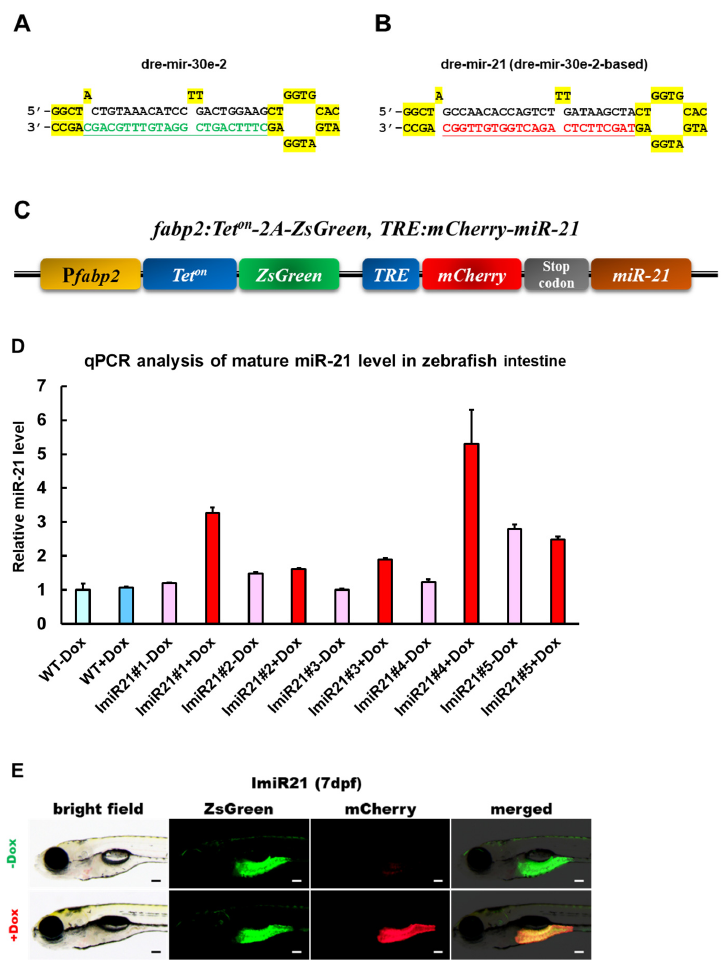
Figure 1. Generation of an intestine-specific and inducible microRNA (miR)-21 transgenic zebrafish. ( A ) Schematic diagram of the stem-loop structure of dre-mir-30e-2. The mature dre-miR-30e sequence (underlined) can be replaced by other mature miRNA sequences. ( B ) Schematic diagram of stem-loop structure of dre-mir-30e-2-based dre-mir-21. The mature miRNA region has been replaced by mature dre-mir-21. ( C ) Schematic diagram of the DNA construct used to generate ImiR-21 [ Tg ( fabp2a:Teton-2A-ZsGreen, TRE:mCherry-miR-21 )]. ( D ) Relative quantification of miR-21 expression using RT-qPCR analysis. ImiR-21#1–5 + doxycycline (Dox) represents five independent transgenic lines. Control: wild-type (WT)—Dox and ImiR-21#1–5—Dox zebrafish. The expression level